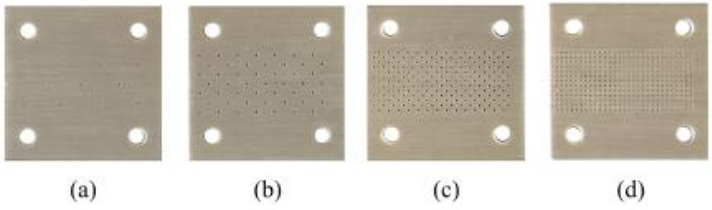
Figure 12. Dependence of the differential phase of the reflection coefficient (i.e., ∆ φ ρ = φ ρ − φ ρ , REF ) with the dielectric constant of the MUT ( a ) and sensitivity ( b ), for the sensor of Figure 11. The measured data points have been obtained by covering the sensing line with the following uncoated materials: Rogers RO3010 ( ε MUT = 10.2), FR4 ( ε MUT = 4.4), Rogers RO4003C ( ε MUT = ε REF = 3.55), PLA ( ε MUT = 3.0, and fabricated by means of a 3D printer). Additionally, the phase of the reflection coefficient has been experimentally obtained with the sensing line uncovered ( ε MUT , air = 1). Reprinted with permission from [64].